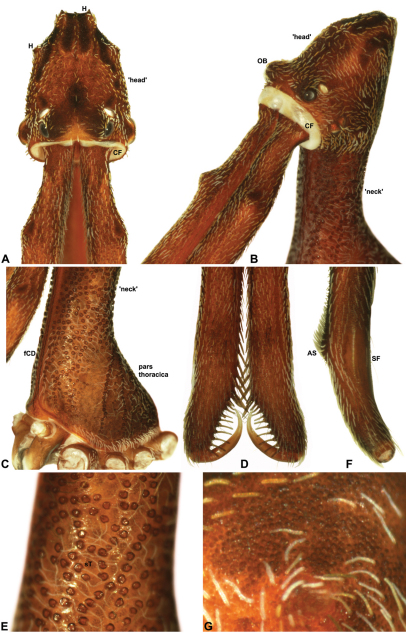
Carapace morphology of Austrarchaea species. A–E, A. alani sp. n.: A, male pars cephalica, frontal view, showing dorsal ‘head’ region, posterior horns (H) and cheliceral foramen (CF); B, female pars cephalica, antero-lateral view, showing ocular bulge (OB), cheliceral foramen (CF) and division of pars cephalica into ‘head’ and ‘neck’ regions; C, male pars thoracica, ‘neck’ and fused cheliceral diastema (fCD), antero-lateral view; D, female chelicerae and peg teeth, frontal view; E, male ‘neck’, lateral view, showing setose tubercles (sT). F–G, A. judyae sp. n.: F, male chelicerae, lateral view, showing accessory setae (AS) and ectal stridulatory file (SF); G, detail of female posterior pars cephalica, lateral view, showing field of densely granulate cuticle.